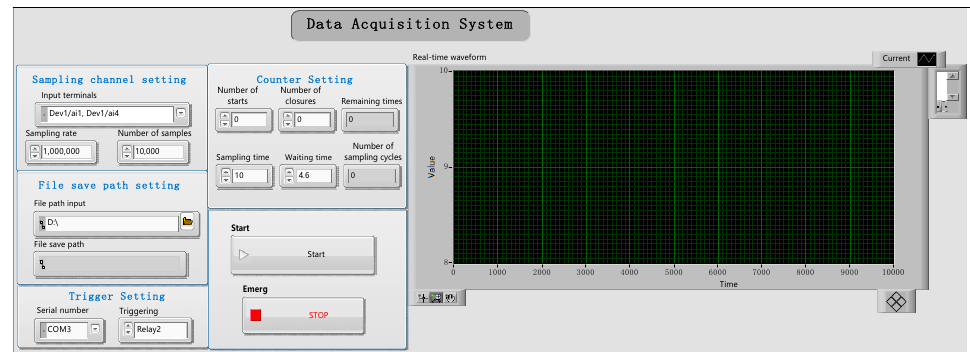
Figure 7. Front-end control panel of the LabVIEW.